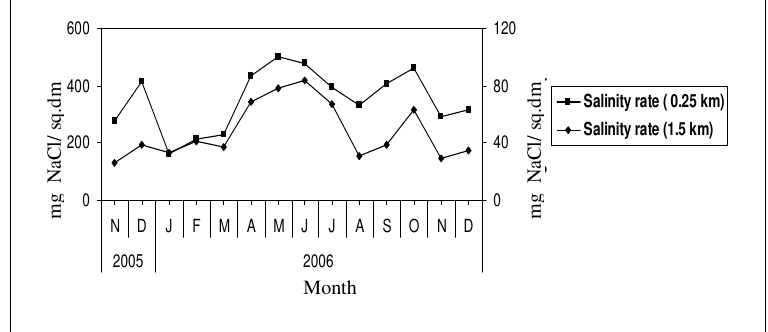
Figure 2 . Atmospheric salinity rate of different distance from sea at marine environment.